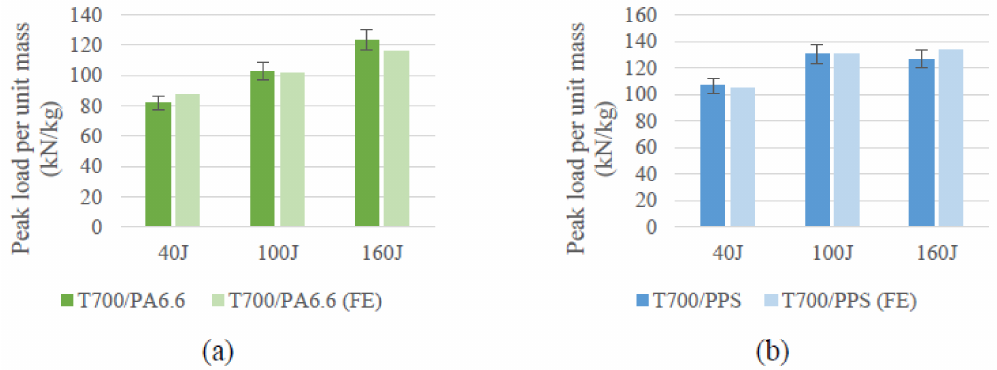
Figure 18. Comparison between experiments and FE with respect to peak load per unit mass for the ( a ) T700/PA6.6 and ( b )